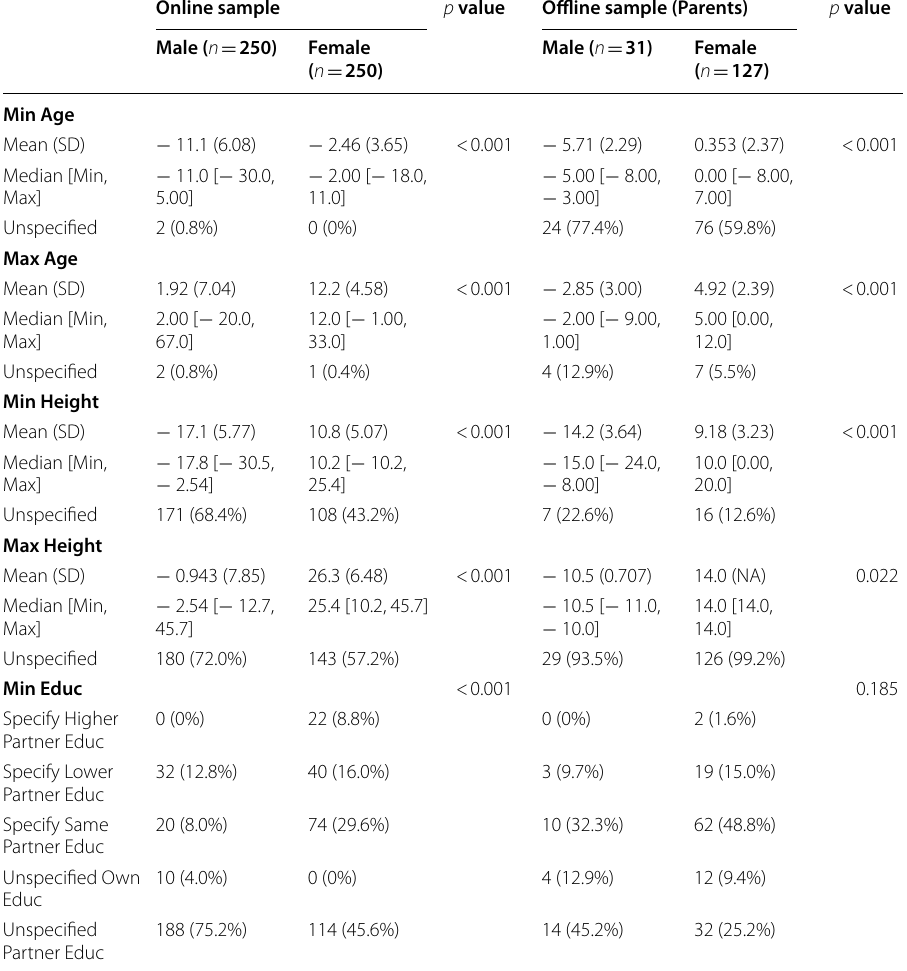
Table 2 Desired Partner Attributes between males and females within the online and offline sample Online sample p